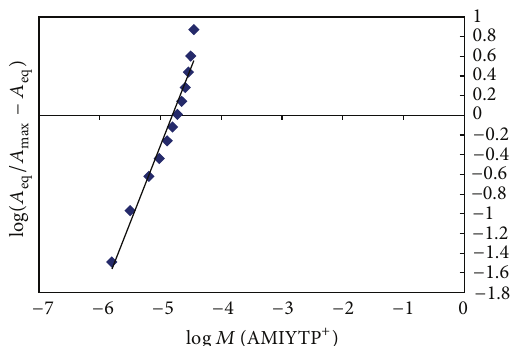
Figure 4: Curve-fitting method for the determination of mole ratio of the Fe(III) to [AMIYTP] + in the Fe(III)-SCN − -[AMIYTP] + complex.